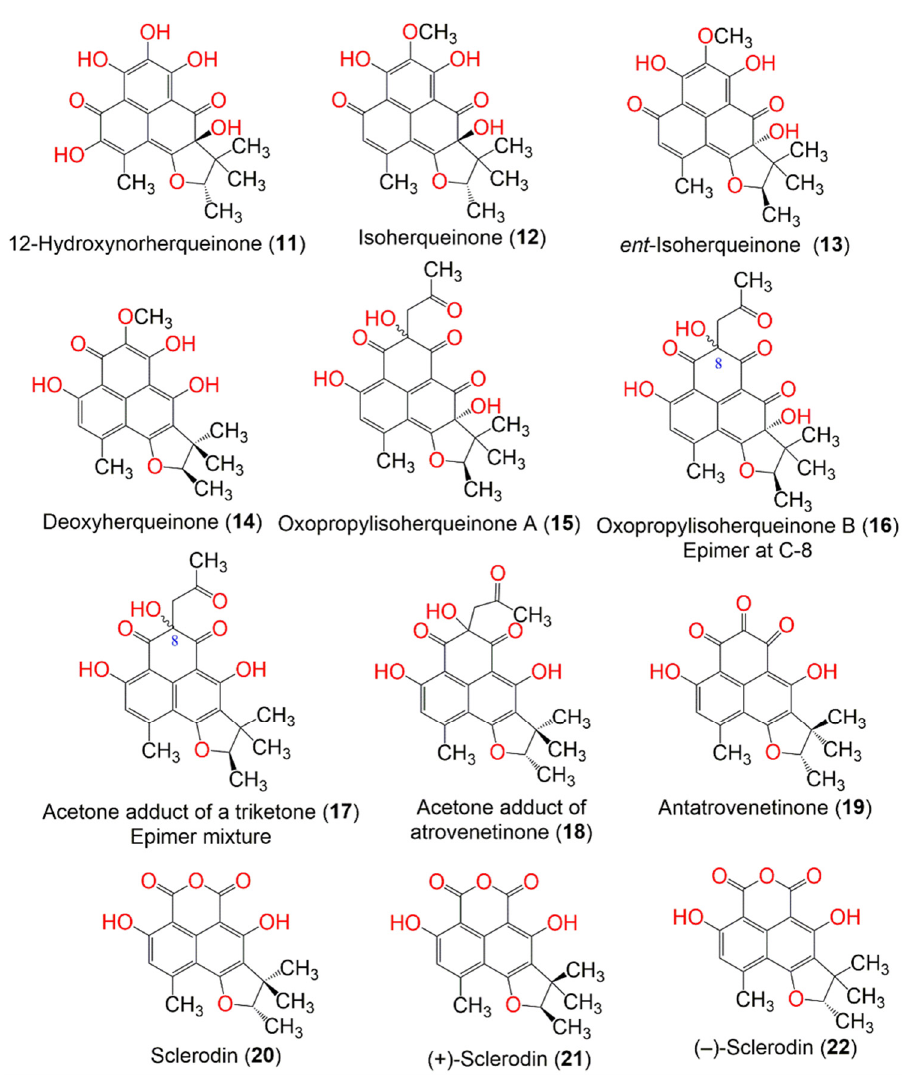
Figure 3. The structures of compounds 23–37 . Macabeo et al. purified 29 , 34 , and 90 from a culture of Pseudolophiostoma sp. MFLUCC- 17-2081 obtained from a dried branch of Clematis fulvicoma . Compounds 29 and 34 con- ferred more potent α -glucosidase inhibition (IC 50 48.7 and 120 µ M, respectively) than N-deoxynojirimycin (IC 50 130.5 µ M). They also potently inhibited the hydrolysis of p -nitro- phenylbutyrate, using porcine lipase. Interestingly, 29 and 34 showed stronger inhibitory potential (IC 50 s 1.0 and 3.4 µ M, respectively) than orlistat (IC 50 9.4 µ M). The in silico tech- niques employed revealed that 29 and 34 exhibited strong binding affinities to porcine pancreatic lipase and α -glucosidase through π – π and H-bonding interactions, while 90 was weakly active (IC 50 > 100 µ M) toward both enzymes